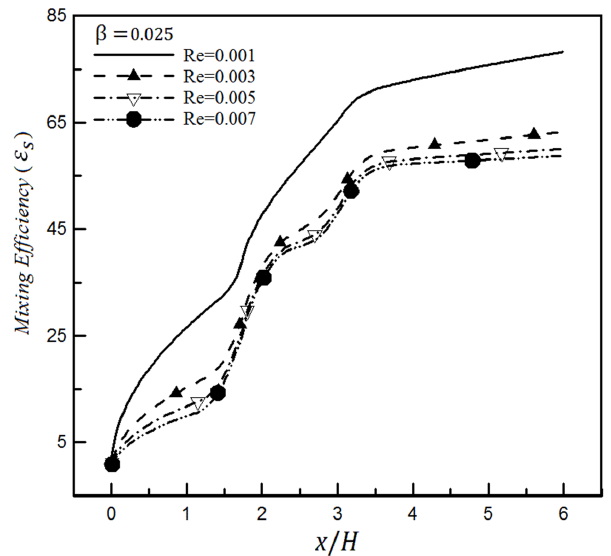
Figure 13. Mixing efficiency changes for a slip coefficient (0.025) and different Reynolds numbers through mixing entropy index.